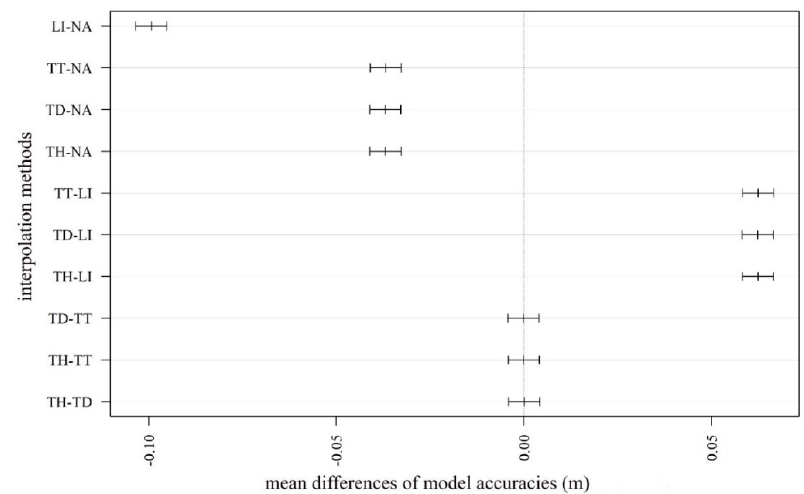
Figure 8. Mean differences by interpolation types (LI: linear interpolation; NA: natural neighbor interpolation; TD: terrain dataset with natural neighbor interpolation; TH: terrain dataset with thinning and natural neighbor interpolation; TT: topo to raster interpolation; error bars: 95% confidence intervals; insignificant differences: where error bars intersected the 0 value, this is shown by the vertical dashed line).